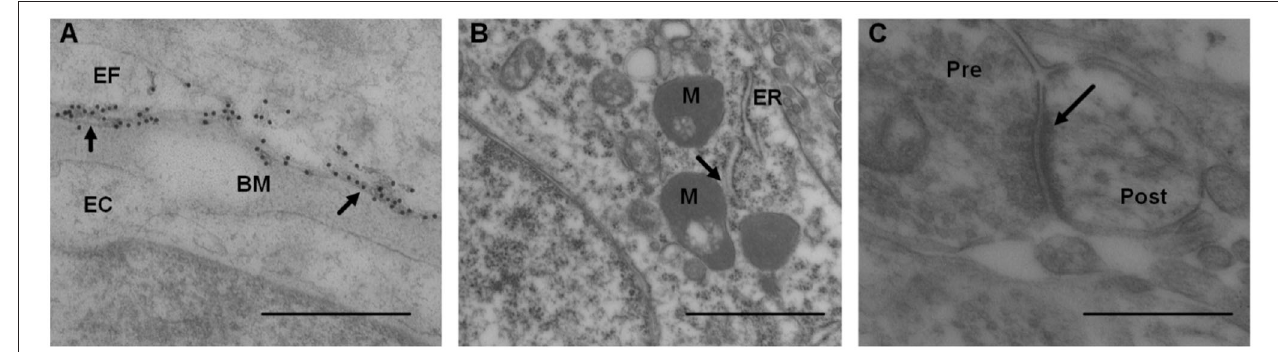
FIGURE 10 | Transmission electron microscopy images of biopsy from right frontal cortex of IIH patients. (A) Expression of AQP4 was shown by immunogold labeling of AQP4 in perivascular astrocytic end-feet (EF) facing basement membrane (BM) and endothelial cells (EC); arrows indicate contact toward BM. Scale bar 500nm. (B) Distance between mitochondria (M) and endoplasmic reticulum (ER) in patients with IIH, denoted mitochondria-ER-contact sites (MERCs; arrow). Shortened distance is indicative of pathology. Scale bar 1 µ m (C) Post-synaptic density (PSD) length (arrow) in IIH, with pre (Pre) and post-synaptic (Post) nerve terminals. Reduced PSD length is indicative of pathology. Scale bar